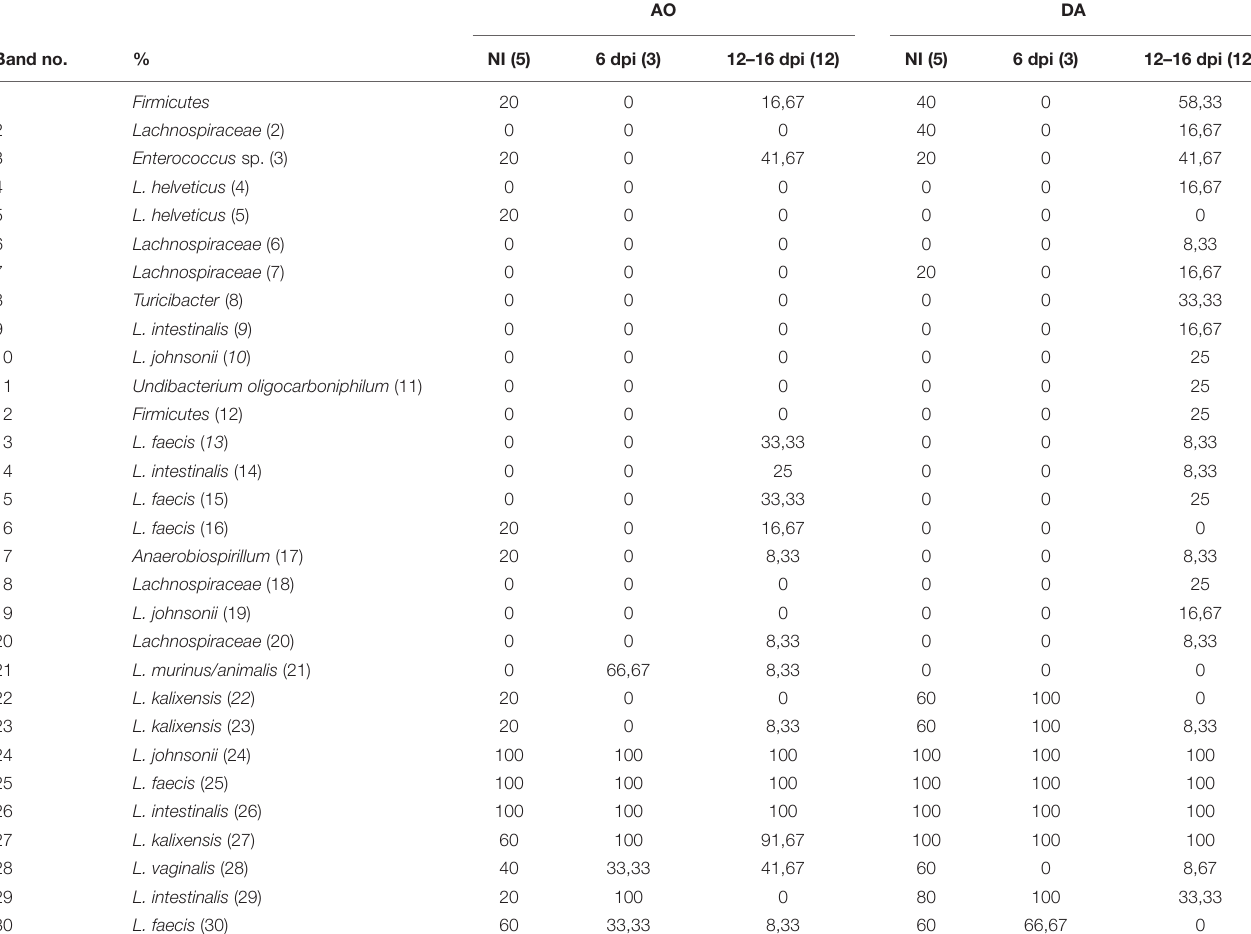
TABLE 2 | The abundance of bands indicated by numbers (1–30) in Figure 1 (given in percentage) in AO and DA rats and in different clinical status.